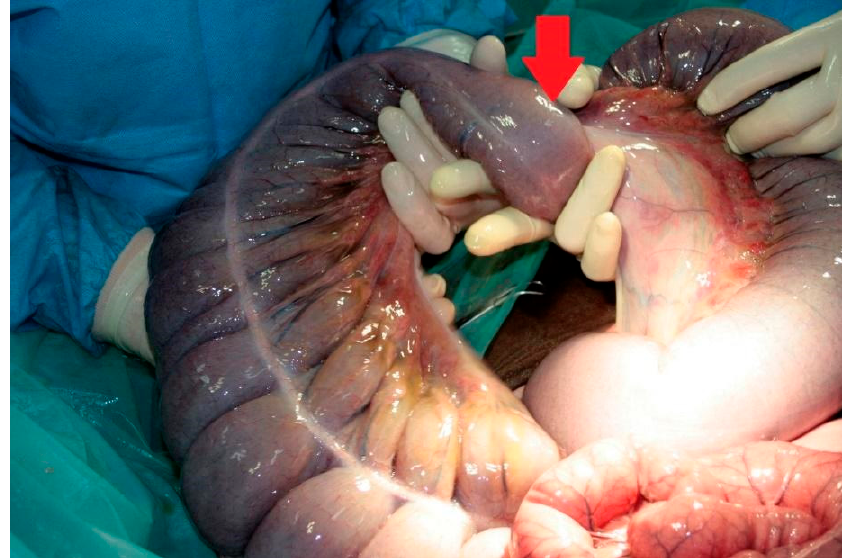
Figure 1. Torsion of the left colon (red arrow).